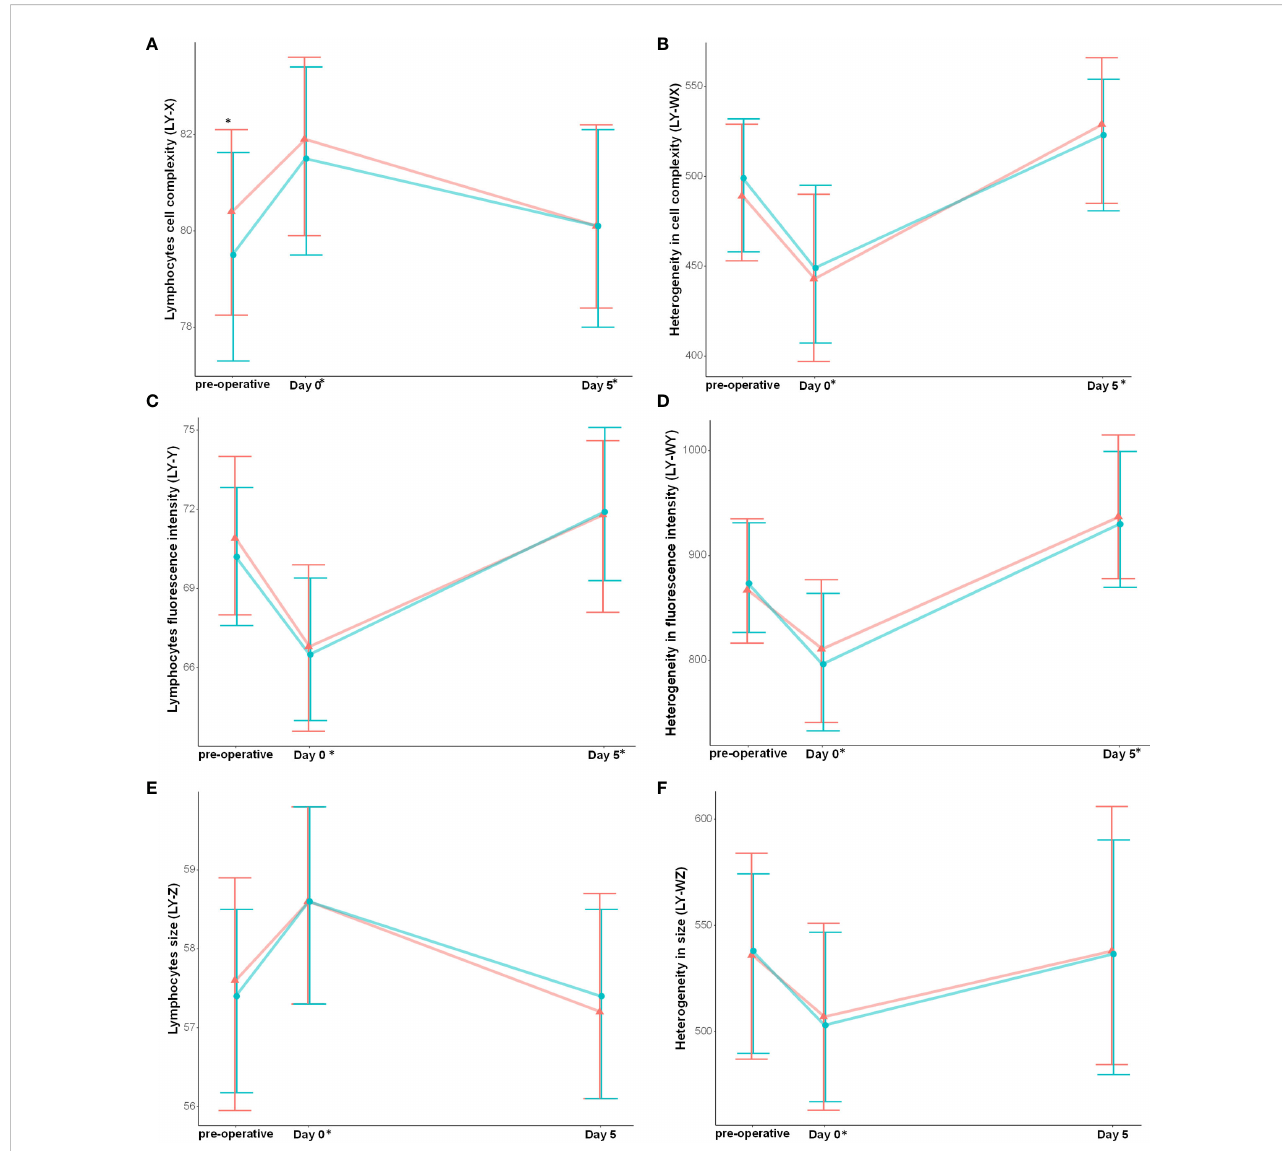
FIGURE 5 Lymphocyte cell populations data are modi fi ed with cardiac surgery and are associated with post-operative complications. (A) Lymphocytes cell complexity, (B) Heterogeneity in cell complexity, (C) Lymphocytes fl uorescence intensity, (D) Heterogeneity in fl uorescence intensity, (E) Lymphocytes cell size, (F) Heterogeneity in lymphocytes cell size. Results are presented as median and interquartile range. *: between groups signi fi cant difference (non-parametric test, p-value were corrected using Bonferroni ’ s method). * on the x-axis report signi fi cant differences from baseline (intragroup comparison with p < 0.05). Red represent patient that developed the composite complication criteria and blue patient who did